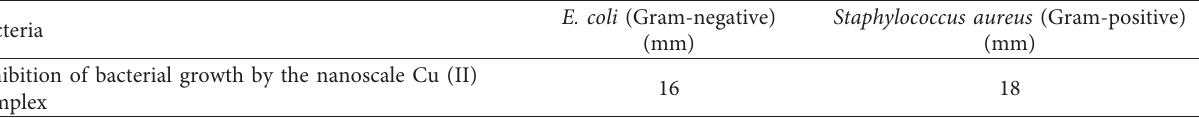
Figure S1: 1 H NMR Schiff base as a ligand. Figure S2: 13 C NMR Schiff base as a ligand. ( Supplementary Materials )